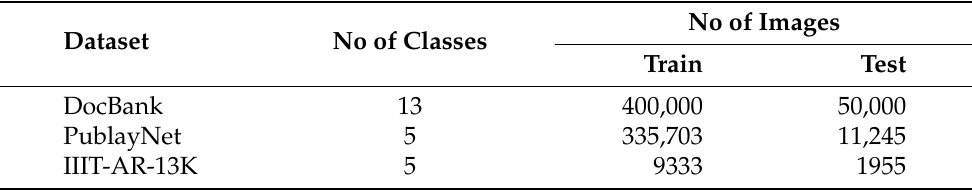
Table 1. The data distribution of datasets used for the experiments. These datasets are divided into train and test sets, with major classes, generally found in documents, spanning over both training and test